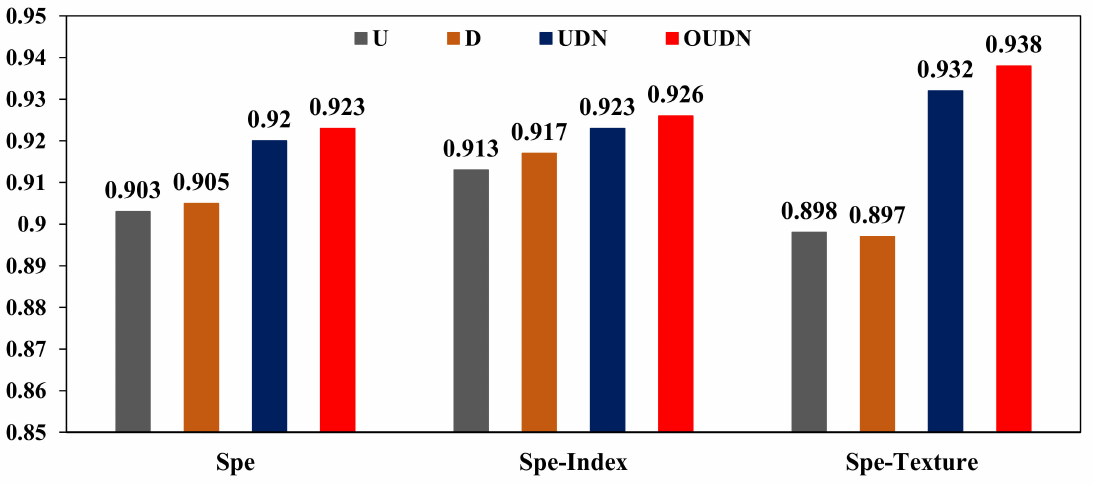
Figure 13. Overall classification accuracies (OA) of di ff erent features based on di ff erent